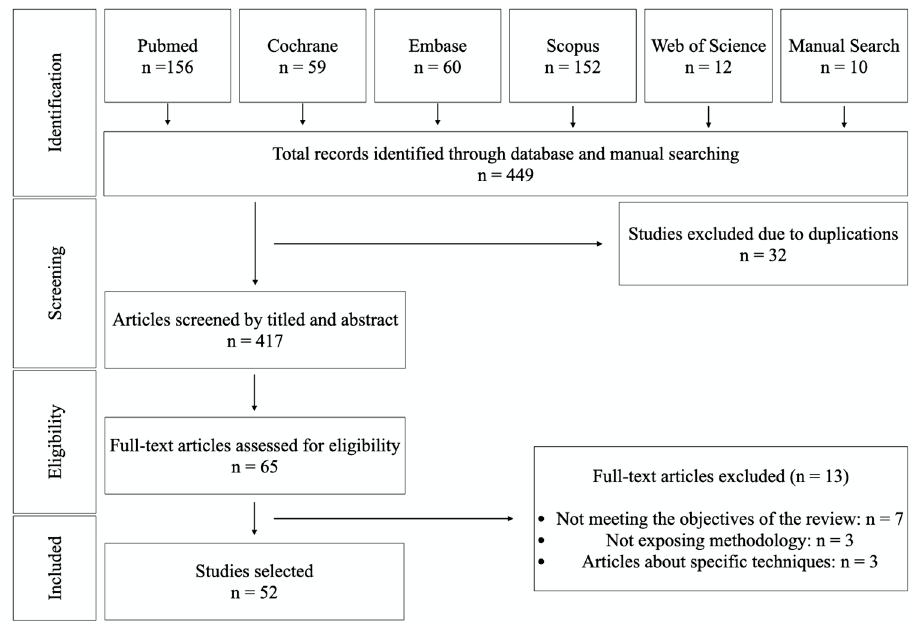
Figure 1. Flow chart of the inclusion and exclusion of studies in this review.